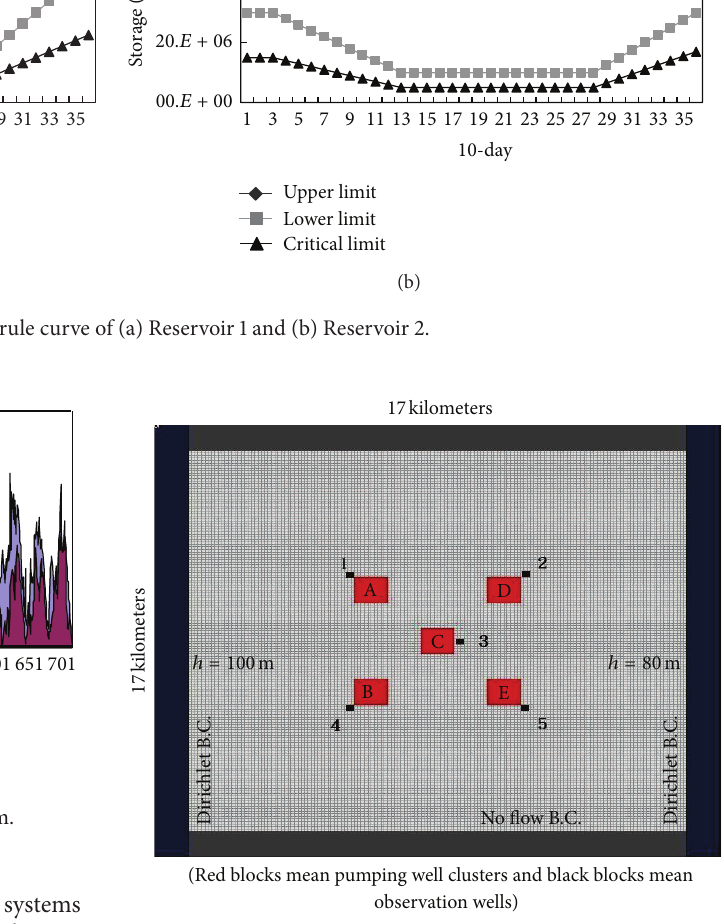
Figure 7: Model of subsurface water system, observation, and pumping wells.